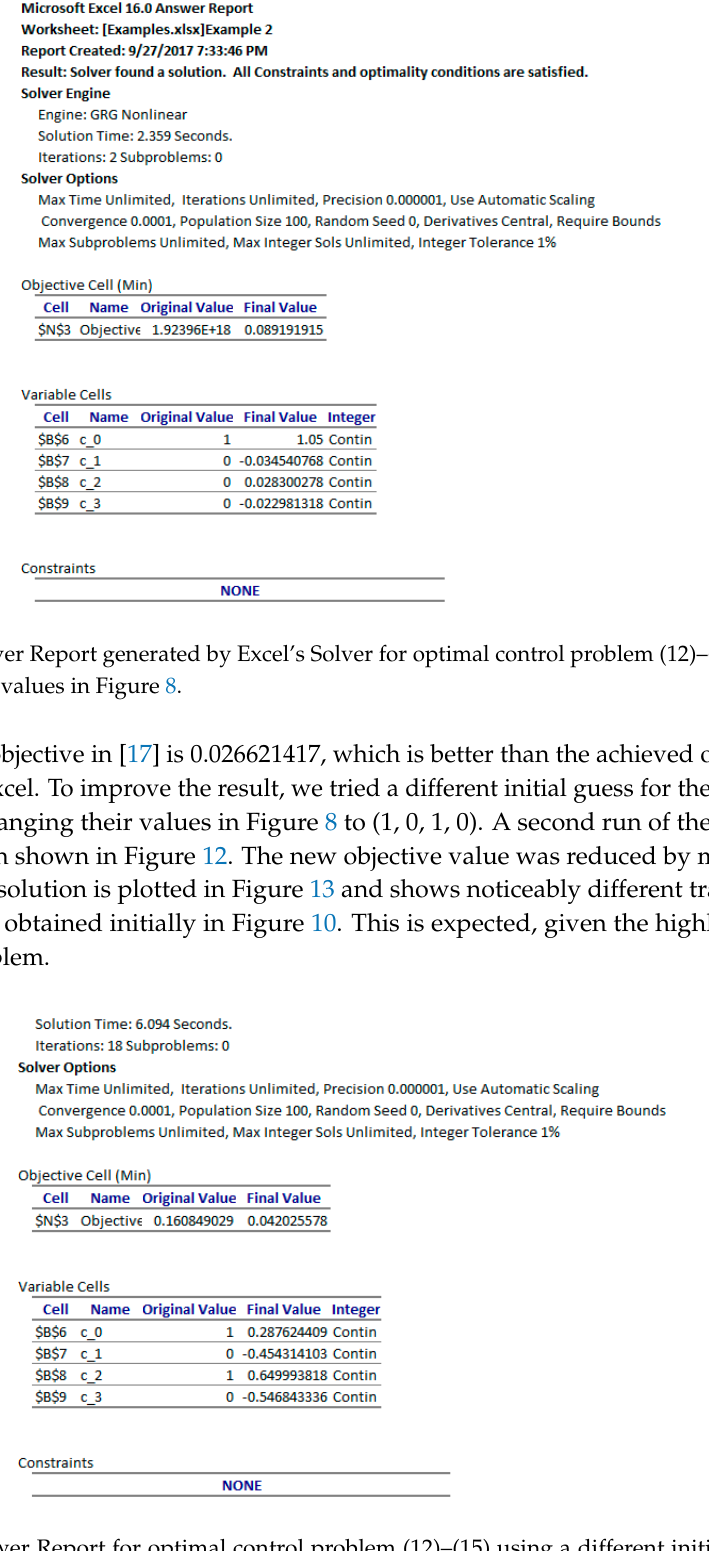
Figure 10. ( a ) Initial trajectories for optimal control problem (12)–(15) based on the default values shown in Figure 8; ( b ) Optimal trajectories found by Excel’s NLP Solver.